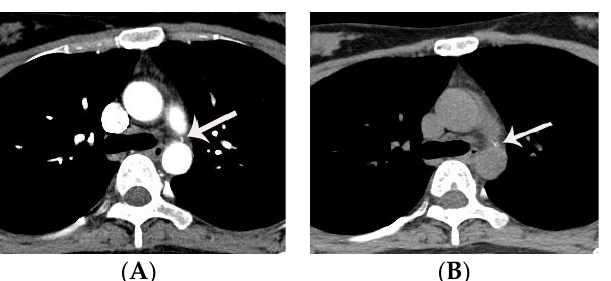
Figure 6. Typical case of calcified ligamentum arteriosum in a 32-year-old female patient. Calcification within the ligamentum arteriosum may be confused with a small PDA if only enhanced chest CT is obtained. Note calcification (arrow on A , B ) within the ligamentum arteriosum at the level of tracheal bifurcation.